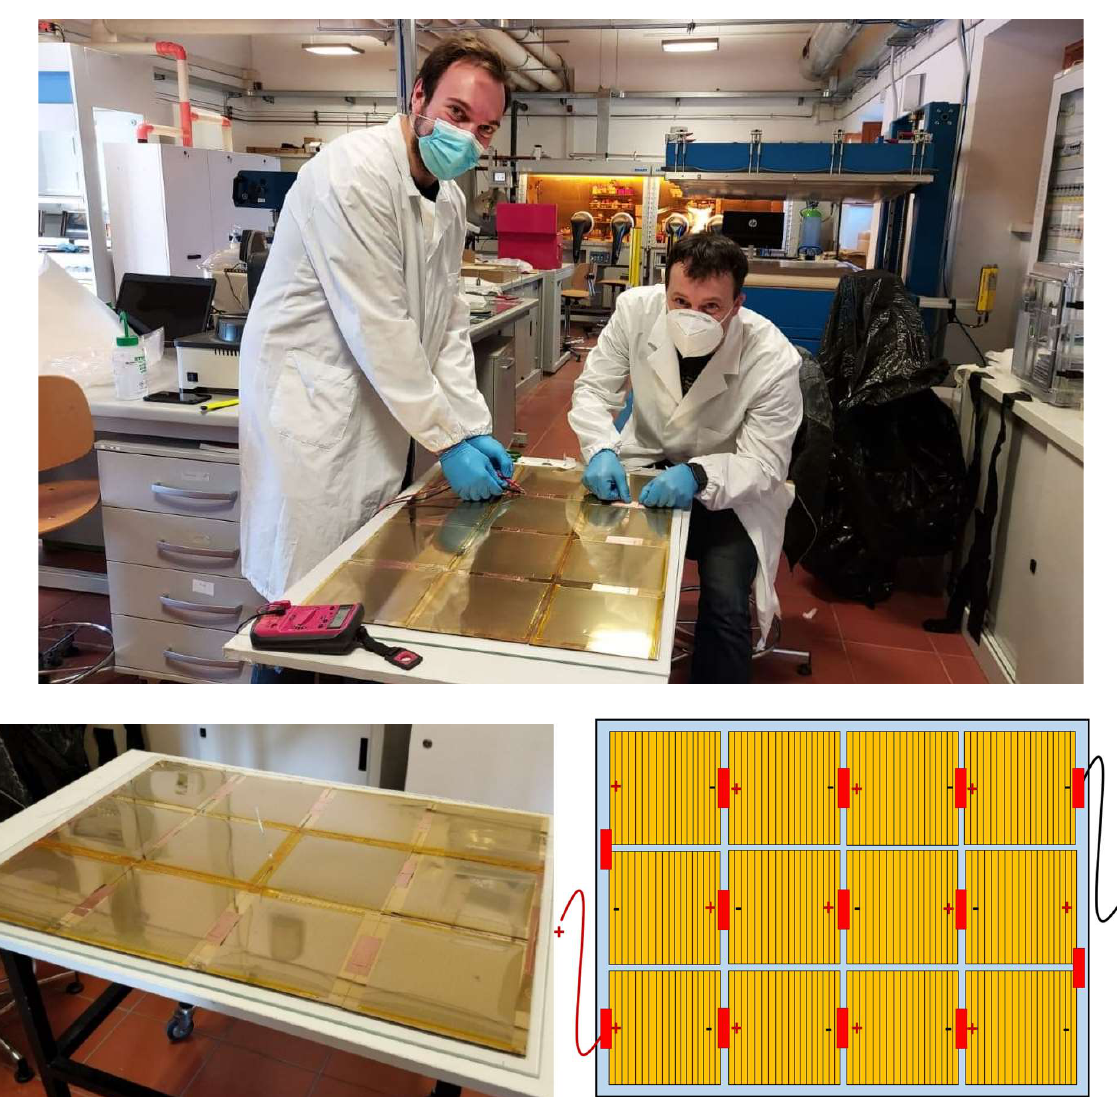
Figure 3. ( Top ) Image of Dr. Luigi Angelo Castriotta and Dr. Enrico Leonardi assembling the modules in the panel; ( bottom left ) picture of modules connected prior to the lamination process; ( bottom right ) scheme of the assembled modules. Ph. by Prof. Aldo Di Carlo.